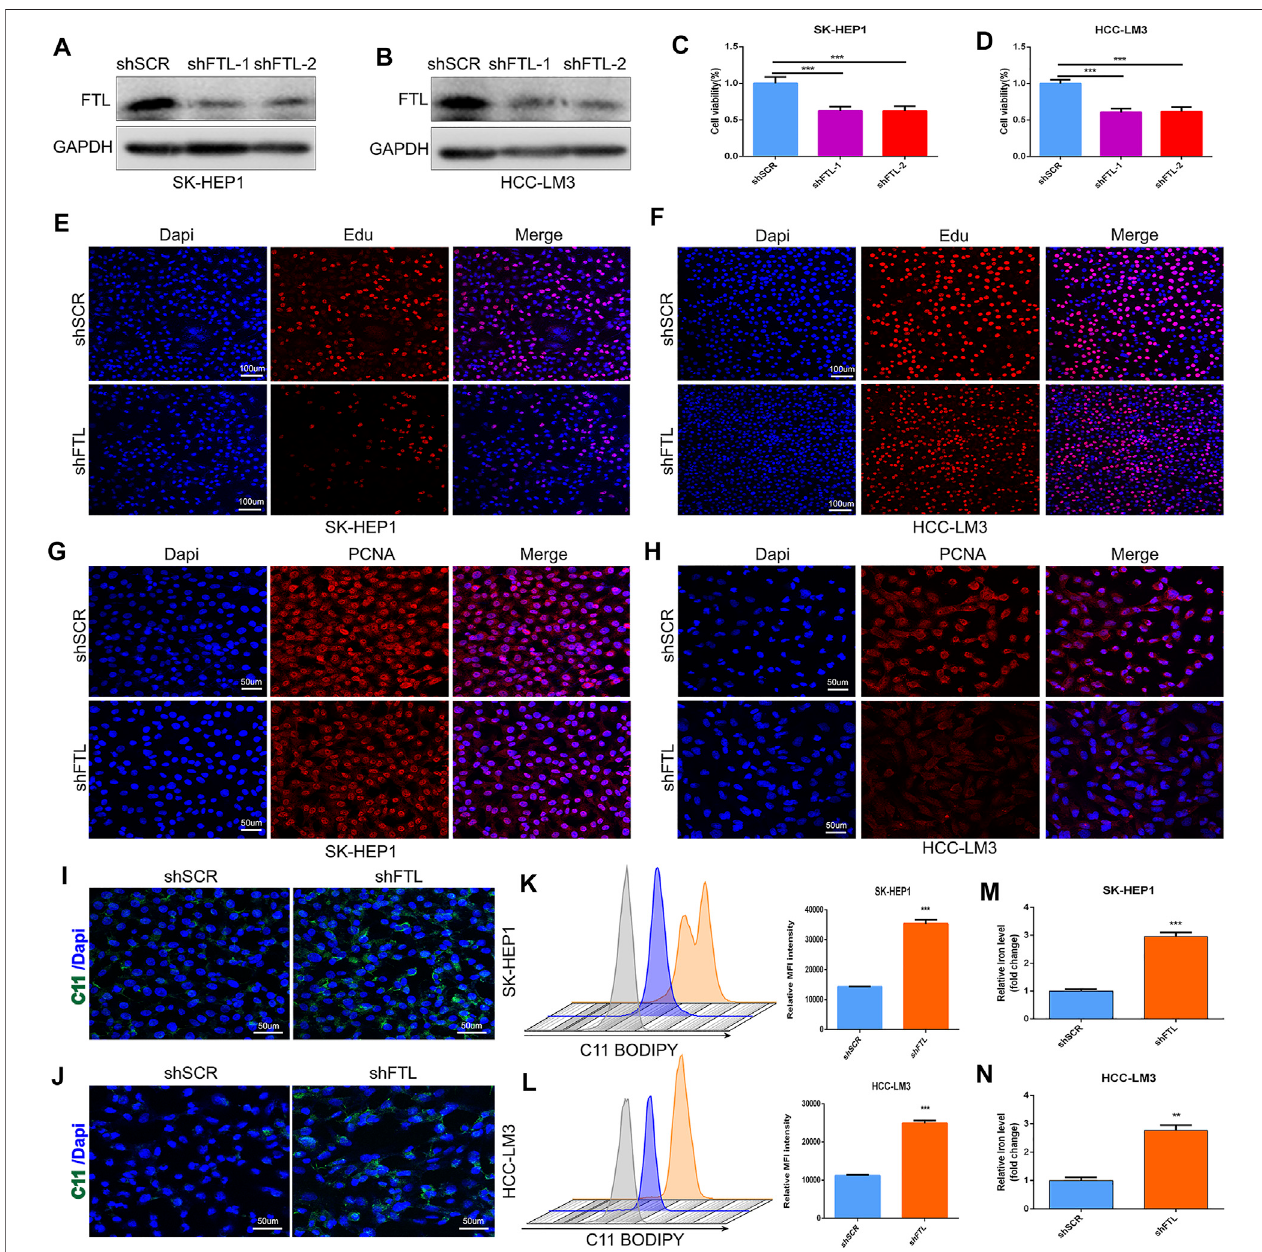
FIGURE 8 | FTL knockdown inhibited HCC-cell proliferation and induced ferroptosis in HCC cells. (A, B) Western blot indicated the FTL inhibition ef fi ciency of FTL shRNAadministrationinSK-HEP1andHCC-LM3cells. (C – F) TheproliferationofSK-HEP1andHCC-LM3cellswasmeasuredbyusingCCK8kit,Eduassay. (G – H) The protein level of PCNA was measured by immuno fl uorescence assay. (I – L) The lipid peroxidation level of SK-HEP1 and HCC-LM3 cells was detected by using C11 BODIPY probe. (M – N) The concentration ofiron level in SK-HEP1 and HCC-LM3 cells with or without shRNA administration. Dataare shown asthe mean ± SD of at least three independent experiments. ** p < 0.01 and *** p <